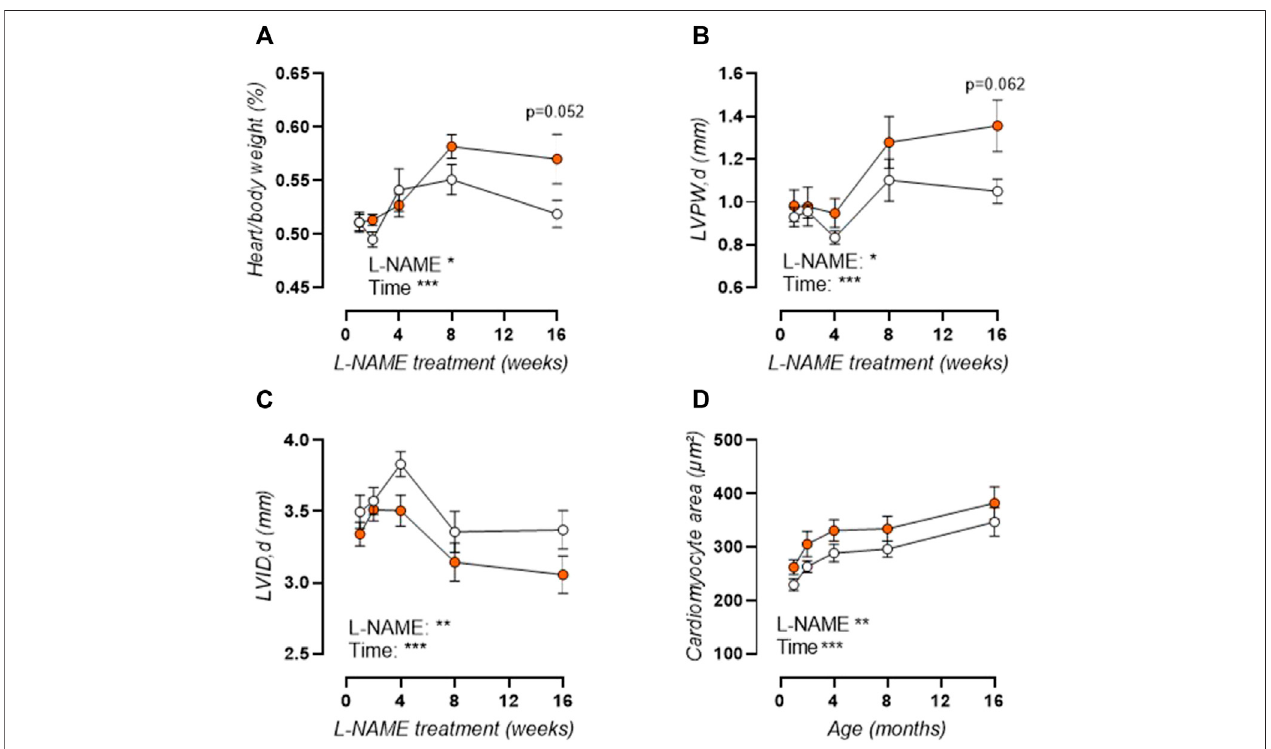
FIGURE 3 | L-NAME induced cardiac hypertrophy. Heart over body weight ratio (A) and echocardiographic assessment of left-ventricular posterior wall (LVPW) thickness (B) and left-ventricular inner diameter (LVID, (C) ) were assessed in L-NAME treated (n ≥ 7) and control (n ≥ 9) mice, and were combined with immunohistochemical anti-laminin staining for measurement of cardiomyocyte cross-sectional area (n = 5) (D) to assess cardiac hypertrophy. Statistical analysis using two-way ANOVA. Overall signi fi cance (bottom) and post-hoc signi fi cance (in graph) are listed. * p < 0.05, ** p < 0.01, *** p < 0.001.